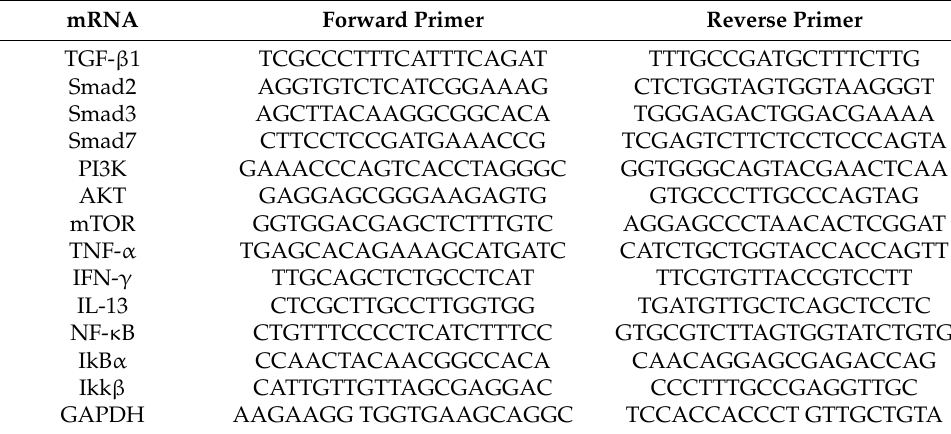
Table 3. Primer information for qRT-PCR